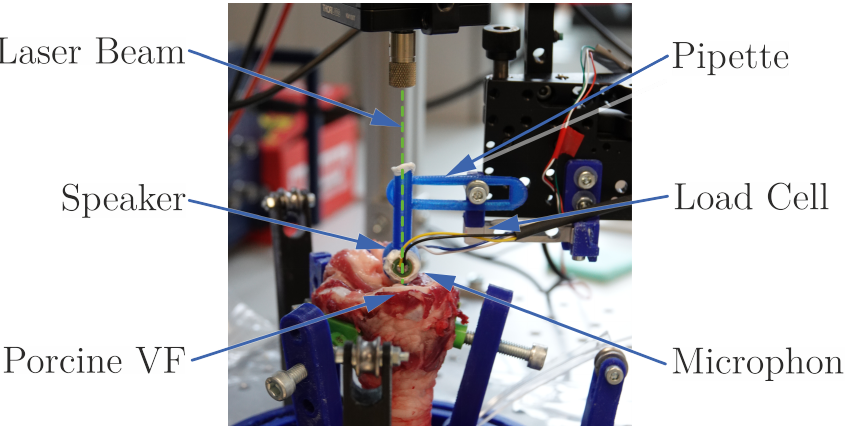
Figure 3. The experimental setup during measurements on a porcine larynx. The pipette is mounted on a load cell, which estimates the contact force. A speaker on the hidden side is producing the pressure signal, which is measured by the built-in microphone. The laser-beam (dashed green line) is projected through the pipette and reflected on the VF surface.